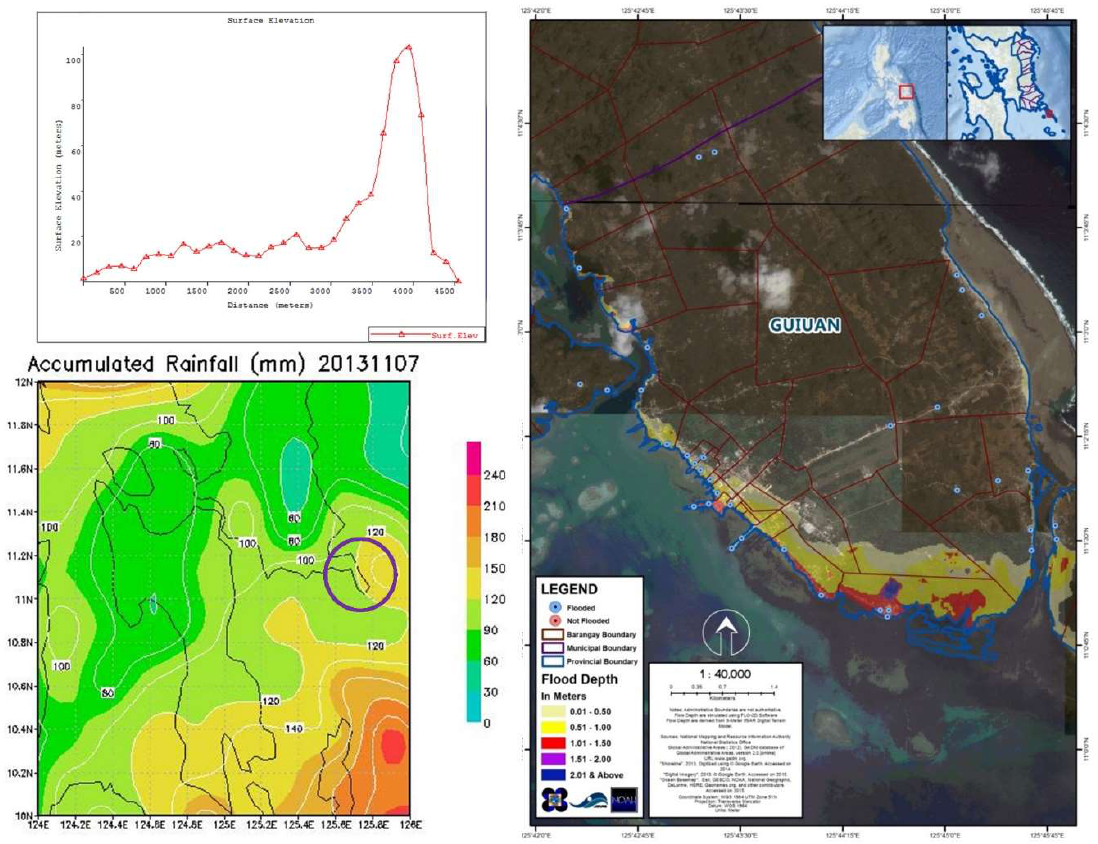
Figure 8. Storm surge inundation and validation points of Guiuan, Eastern Samar. The upper left figure shows the transect elevation for a cross-sectional transect (blue arrow) in the storm surge inundation map (right image). The lower left image shows accumulated rainfall during the event in mm/day, the area circled in purple is the area shown on the right panel.